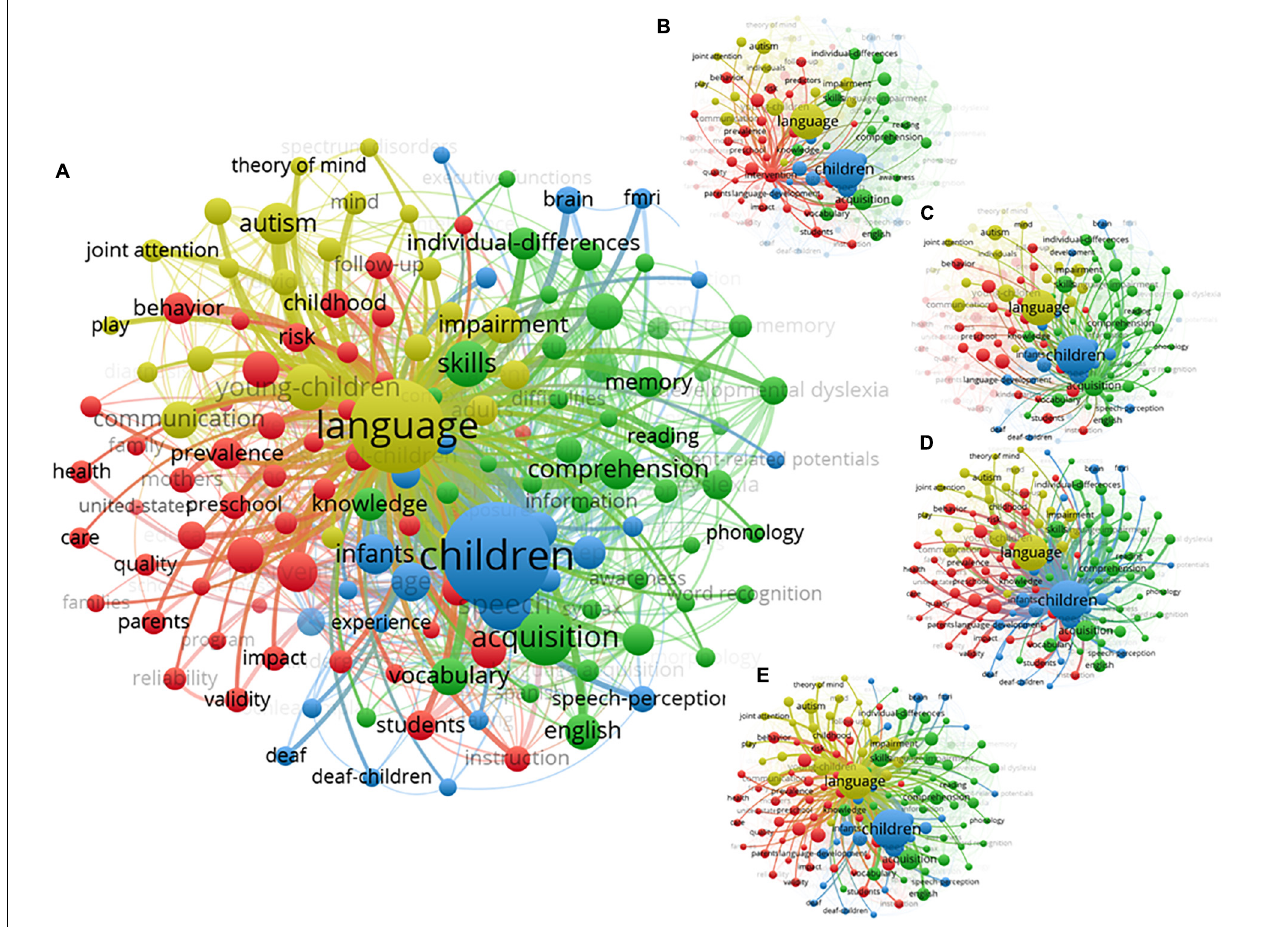
FIGURE 8 | Co-keyword network visualizations. (A) Co-keyword network visualization of four clusters; (B) co-keyword network visualization of Cluster # 1; (C) co-keyword network visualization of Cluster # 2; (D) co-keyword network visualization of Cluster # 3; (E) co-keyword network visualization of Cluster #